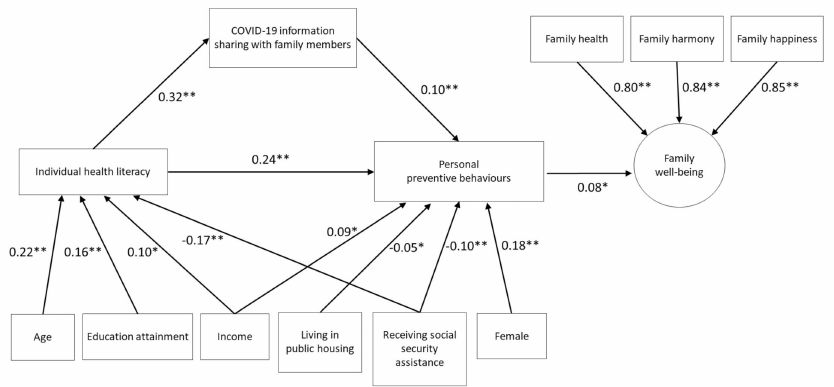
Figure 3. Standardized coe ffi cients from the structural equations model (Model C) for assessing the mediating e ff ects of COVID-19 information sharing with family members on preventive behaviours and family